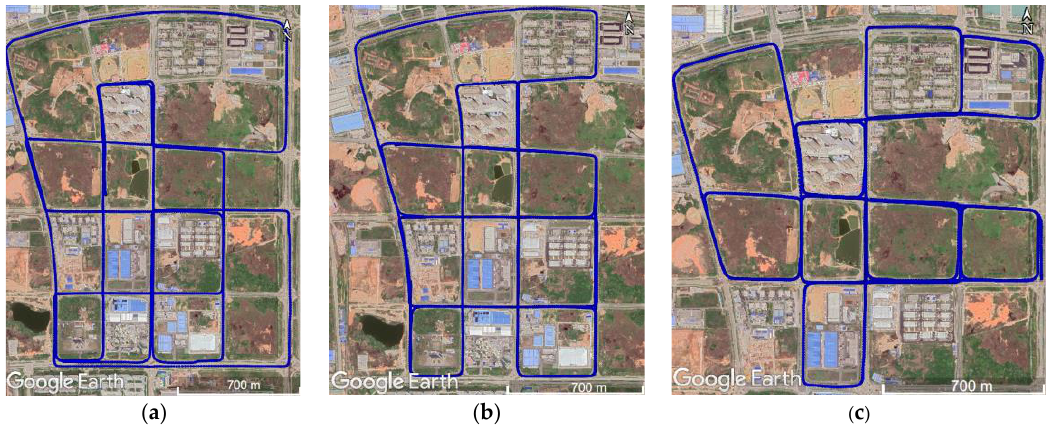
Figure 6. Trajectories of the open-sky tests. ( a ) Test #1, ( b ) Test #2, and ( c ) Test #3.